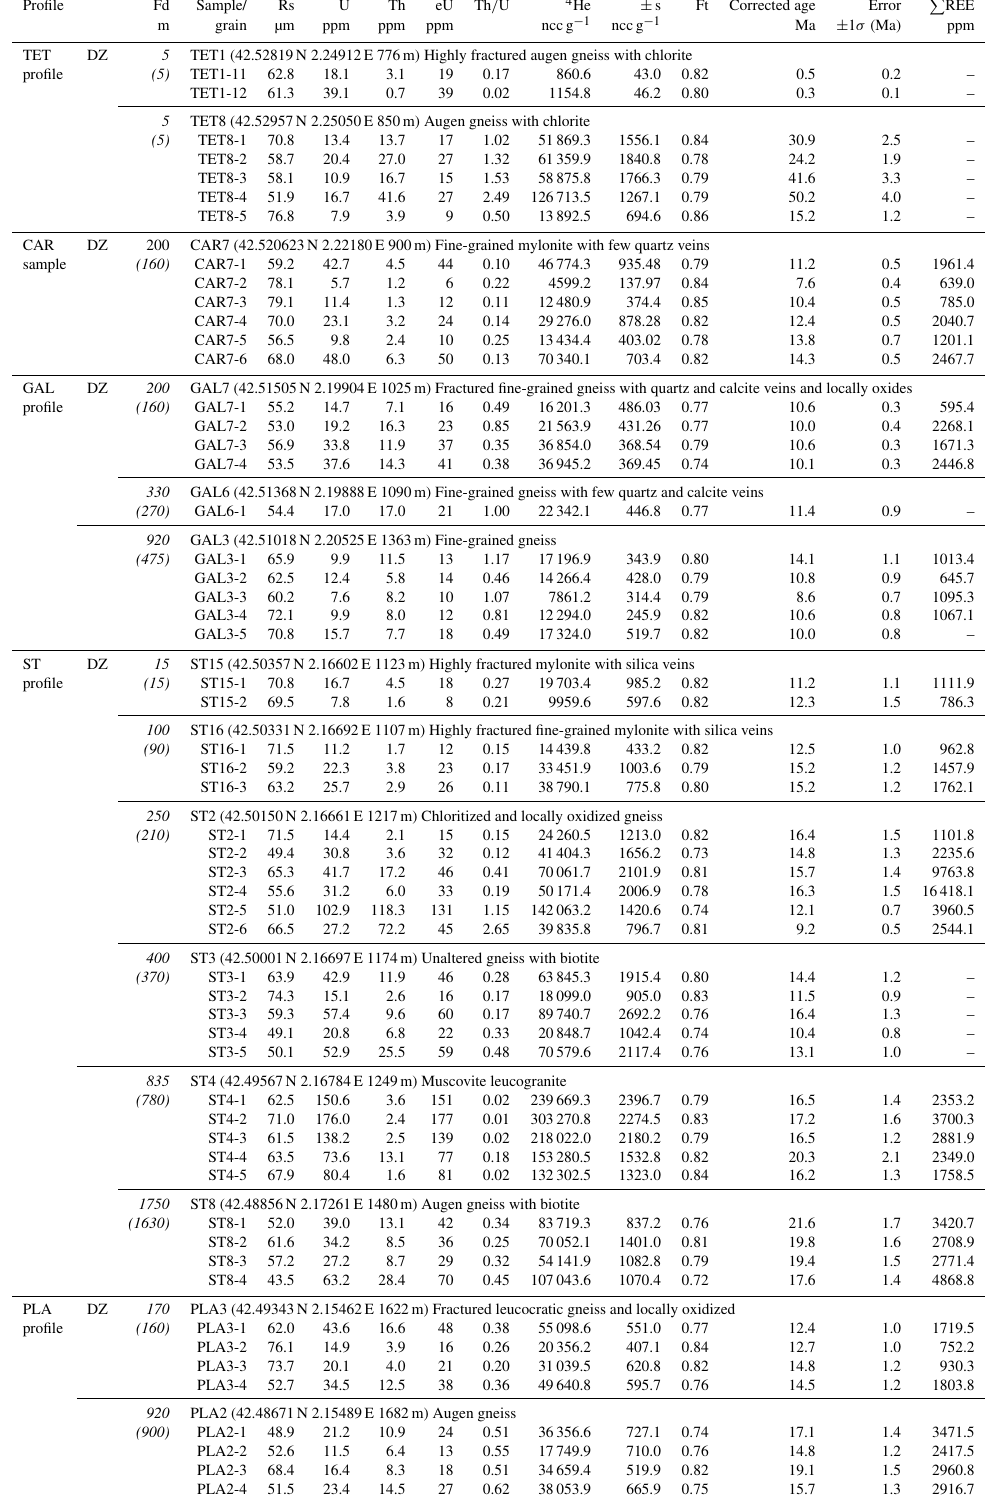
Table 1. AHe ages of footwall samples.